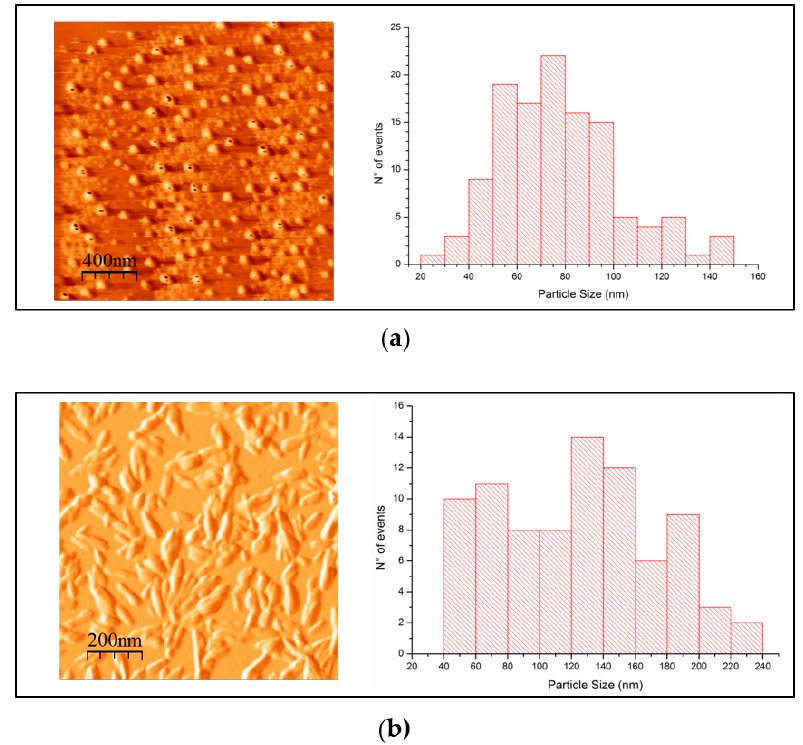
Figure 9. Atomic Force Microscopy images and particle size histogram for IL-treated pulp samples: ( a ) treated pulp with [emim][Cl]; ( b ) treated pulp with [bmim][HSO 4 ].